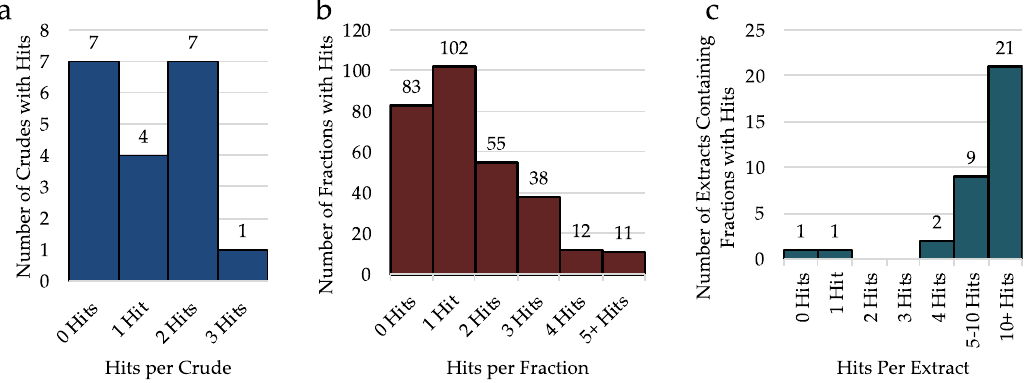
Figure 4. Number of hits per crude, fraction, or extracts once pre-fractionated. ( a ) Number of hits per crude extract (19 crude extracts total). ( b ) Number of hits per fraction (301 fractions total). ( c ) Number of hits per extract, once pre-fractionated (34 crude extracts total).